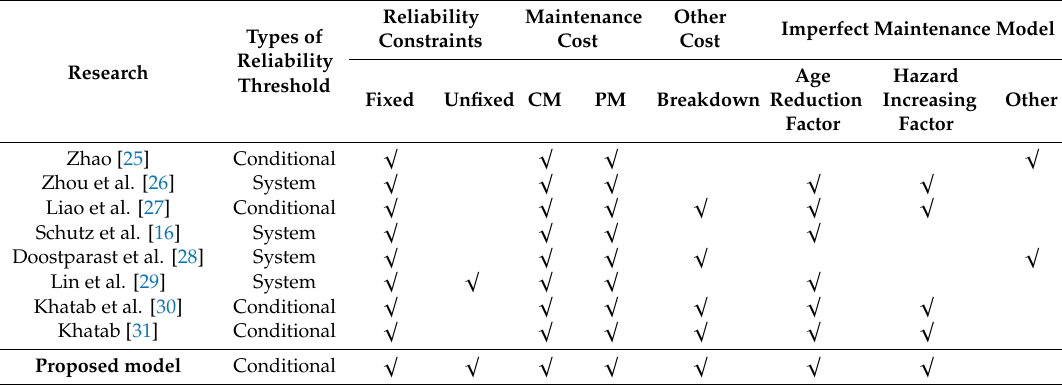
Table 1. Author contribution in the reliability-based PM model based on reliability constraints, maintenance costs, and imperfect maintenance